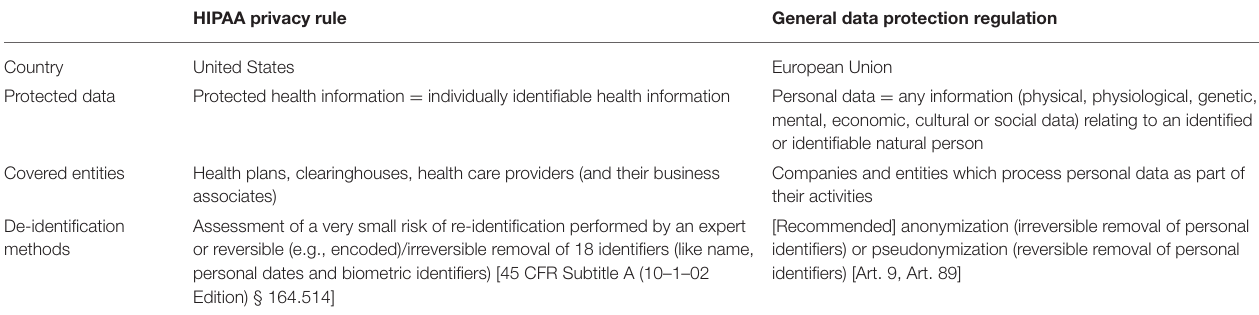
TABLE 1 | Main differences between US and EU regulations regarding data